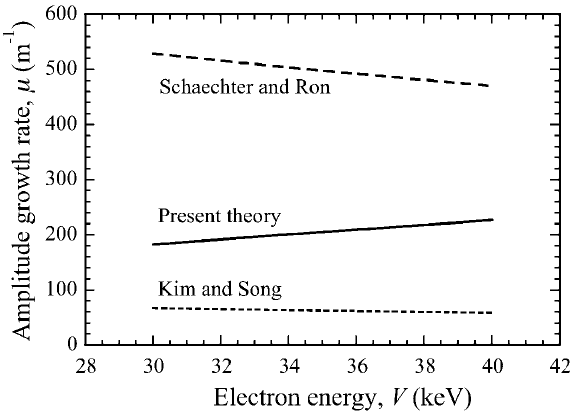
FIG. 4. Amplitude growth rate (per unit distance) for the experimental parameters of Urata and Walsh: present theory (solid line), Kim and Song (dotted line), Schaechter and Ron (dashed line).